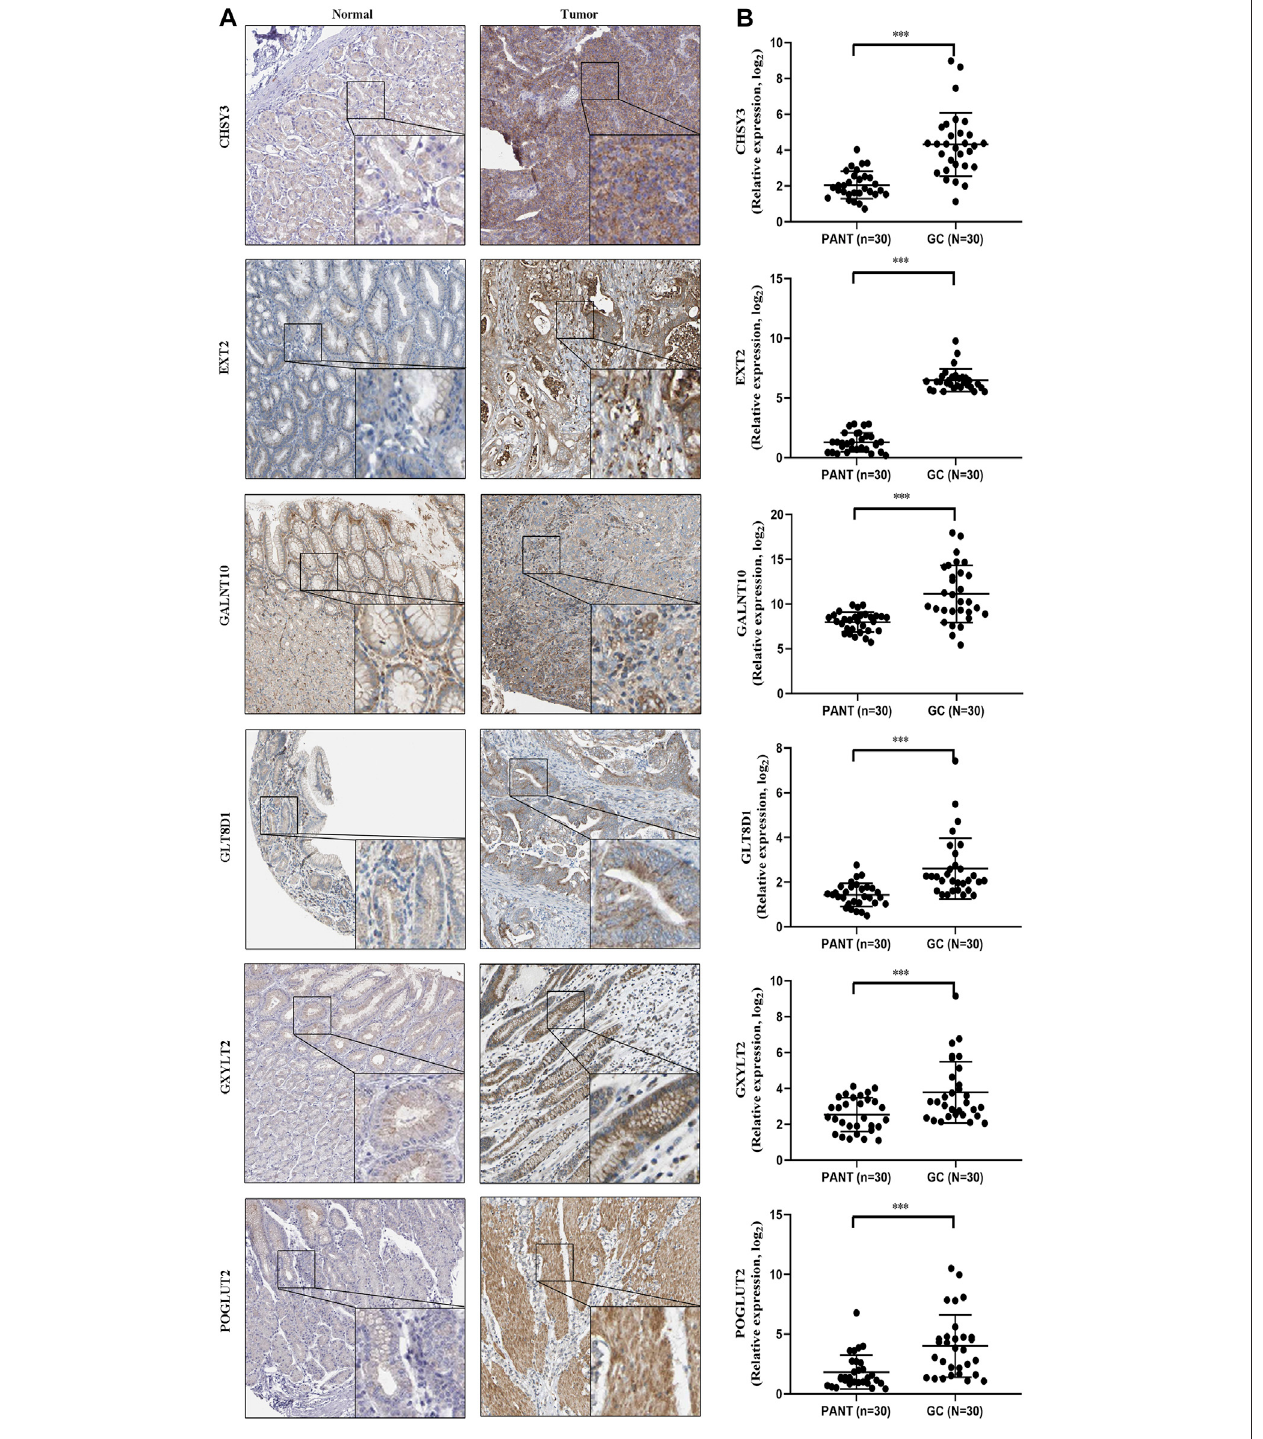
FIGURE9| TheexpressionofsixmarkergenesinGC. (A) Representativeimmunohistochemistryimagesofsixmarkergenesexpression innormaltissuesandGC tissues. (B) Six marker genes mRNA levels are shown for the GC and normal tissues.